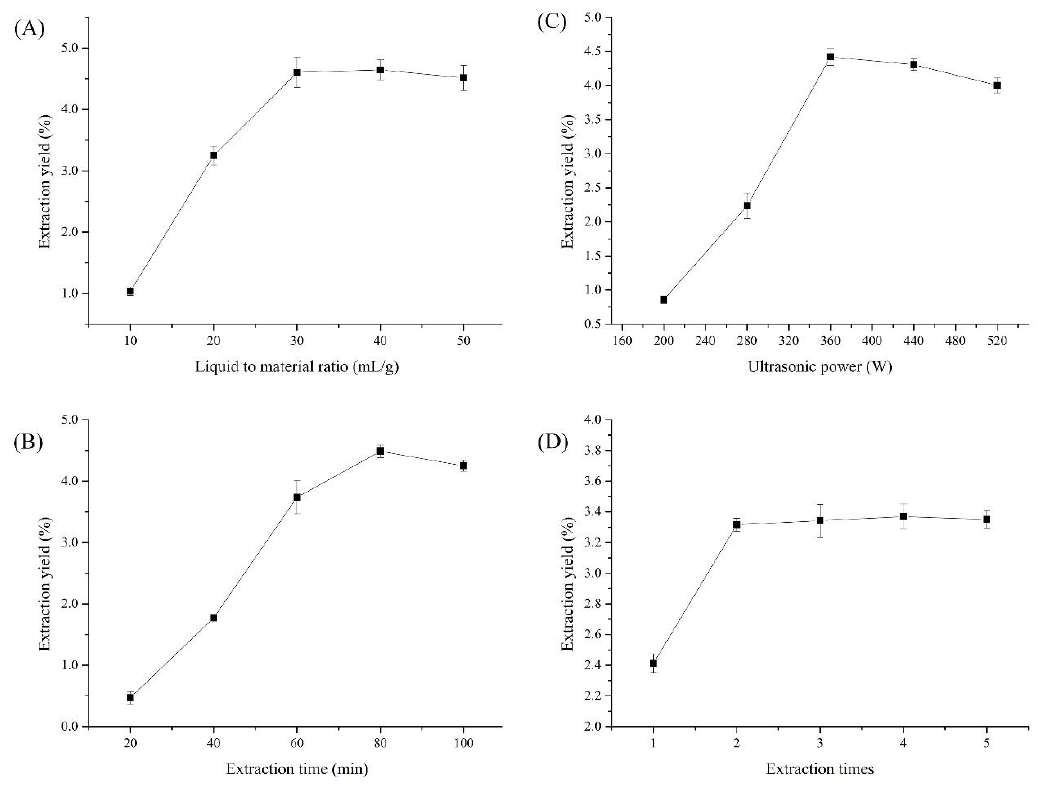
Figure 1. Single-factor experimental results for cCPP extraction, ( A ) Liquid to material ratio; ( B ) Extraction time; ( C ) Ultrasonic power; ( D ) Extraction times.